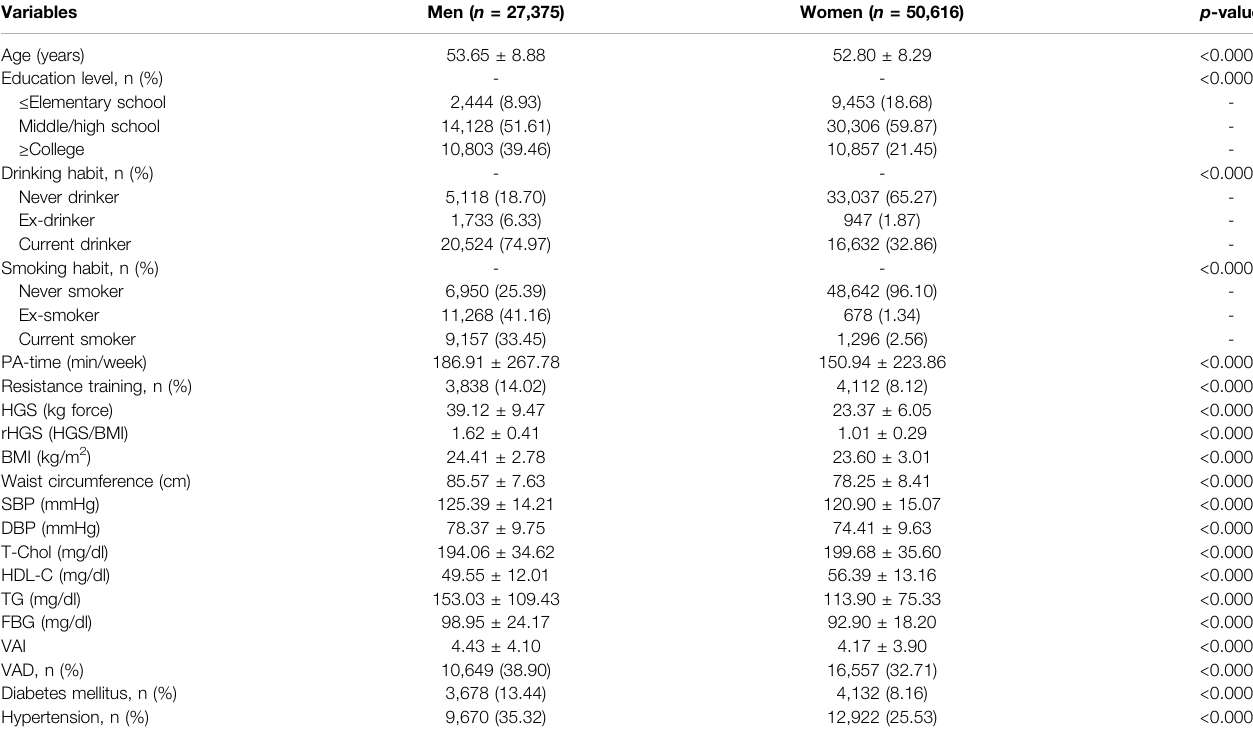
TABLE 1 | Characteristics of study